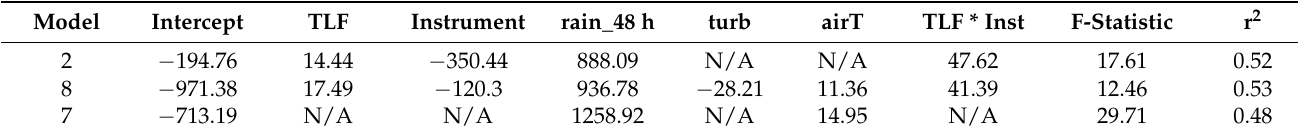
Table 3. Model coefficients, model fit, and F-statistics for competing models (“TLF” = tryptophan- like fluorescence, “rain_48 h” = 48 h antecedent rainfall, “turb” = turbidity, “airT” = air temper- ature, and “TLF * Inst” = interaction variable between TLF and the instrument used to record it; N/A = not applicable).